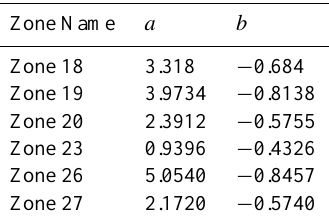
Figure 6. Dividing cells in the study area (250*250m) (İnce, 2005)